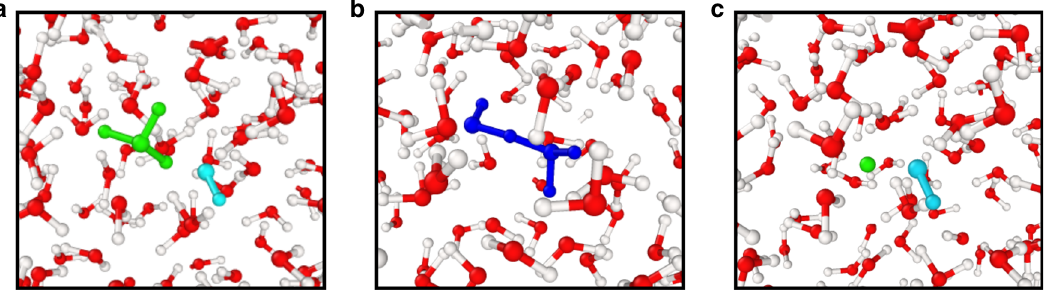
Fig. 6 Snapshots of high pressure simulations. Snapshots extracted from fi rst principles simulation of a 0.68 M NaCl solution at 1000 K and 11 GPa, showing short-lived OH þ and OH − ( a ), H 4 O 2 ( b ) and OH − and H + ( c ), shown with cyan, green and blue spheres, respectively. 3